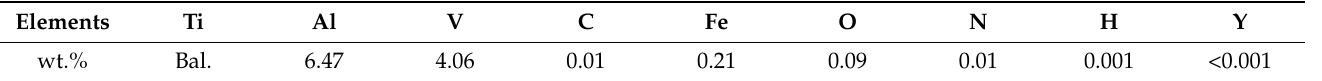
Table 1. Nominal chemical composition of Ti6Al4V-ELI in